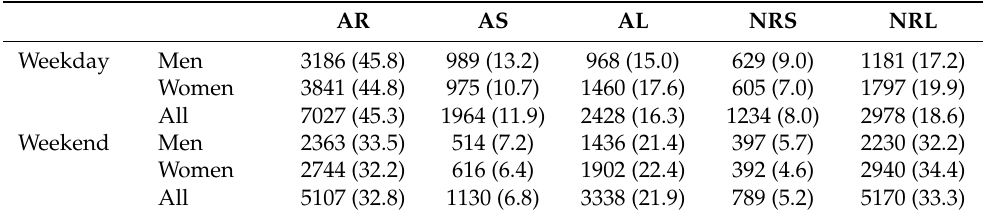
Table 5. Number (weighted percentage) of respondents adhering to NSF sleep age-specific recom- mendations.